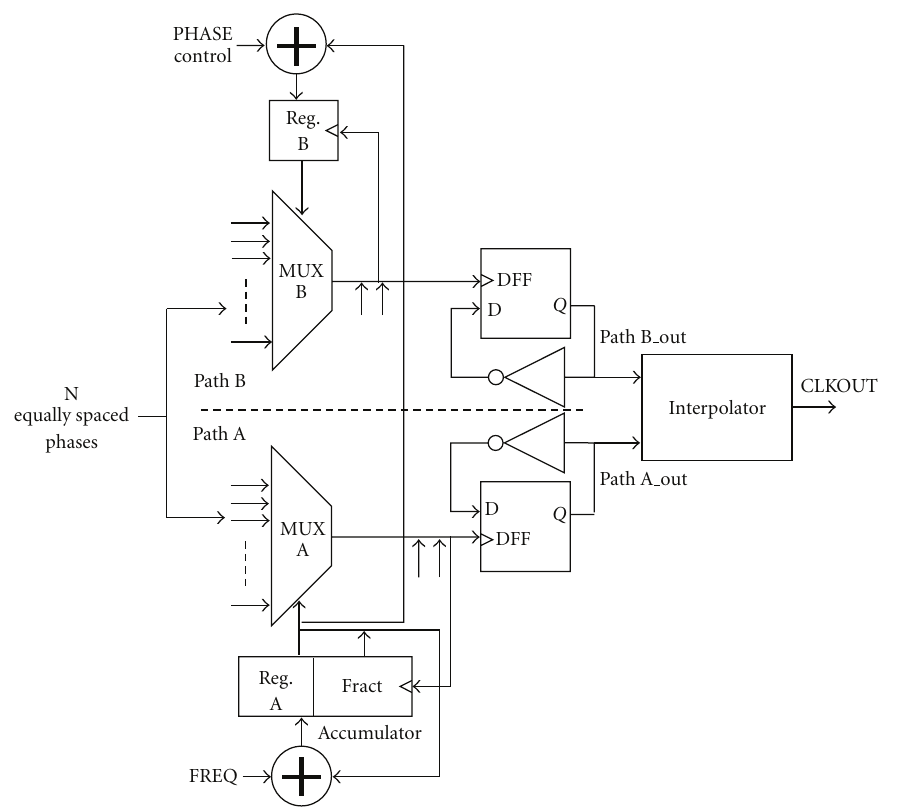
Figure 4: Block diagram of proposed interpolated flying adder.